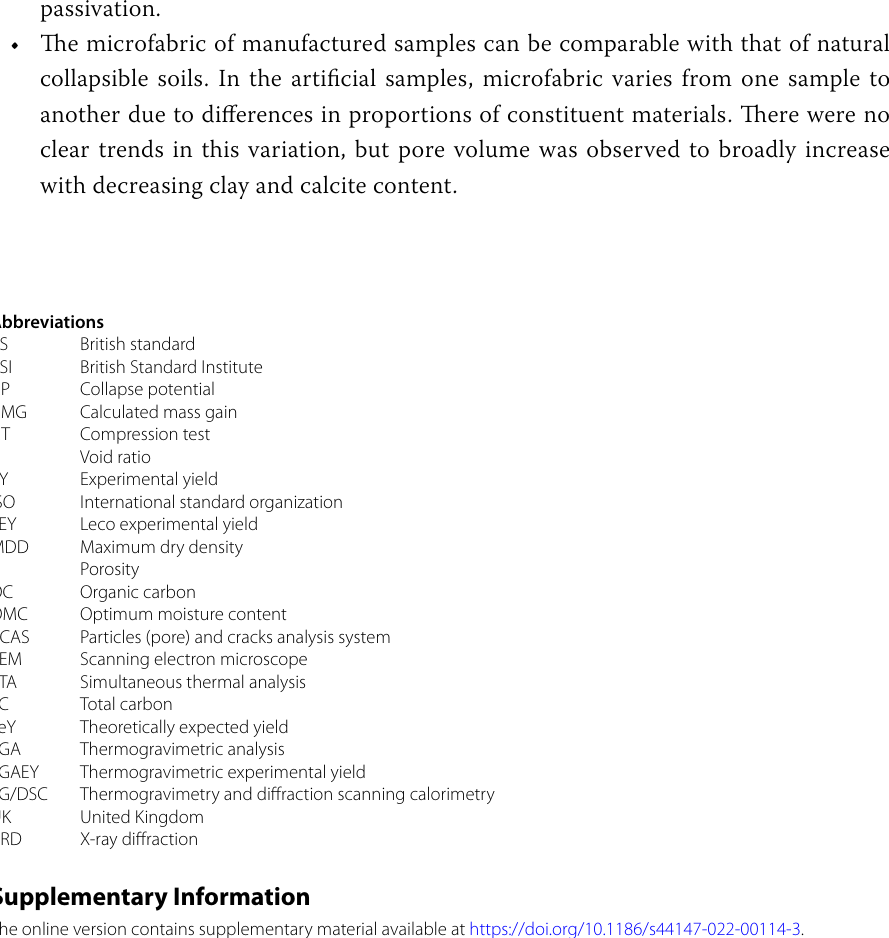
Additional file 1: Figure S1. Stages of the methodological framework to produce loose-structured samples. Table S1. Properties of Polwhite E China clay reported by supplier. Table S2. Properties of the hydrated lime as presented by Lafarge Tarmac, 2016. Table S3. Index properties of Primary Soils with varying proportions of lime (uncarbonated). Figure S2. Moisture content – dry density relationship of primary soils with varying lime contents. Table S4. X-Ray diffraction angles of minerals as adapted from the literature. Figure S5. a and b - SEM micrographs of manufactured samples and their microporosity analysis using PCAS. Black areas represent pores in the PCAS